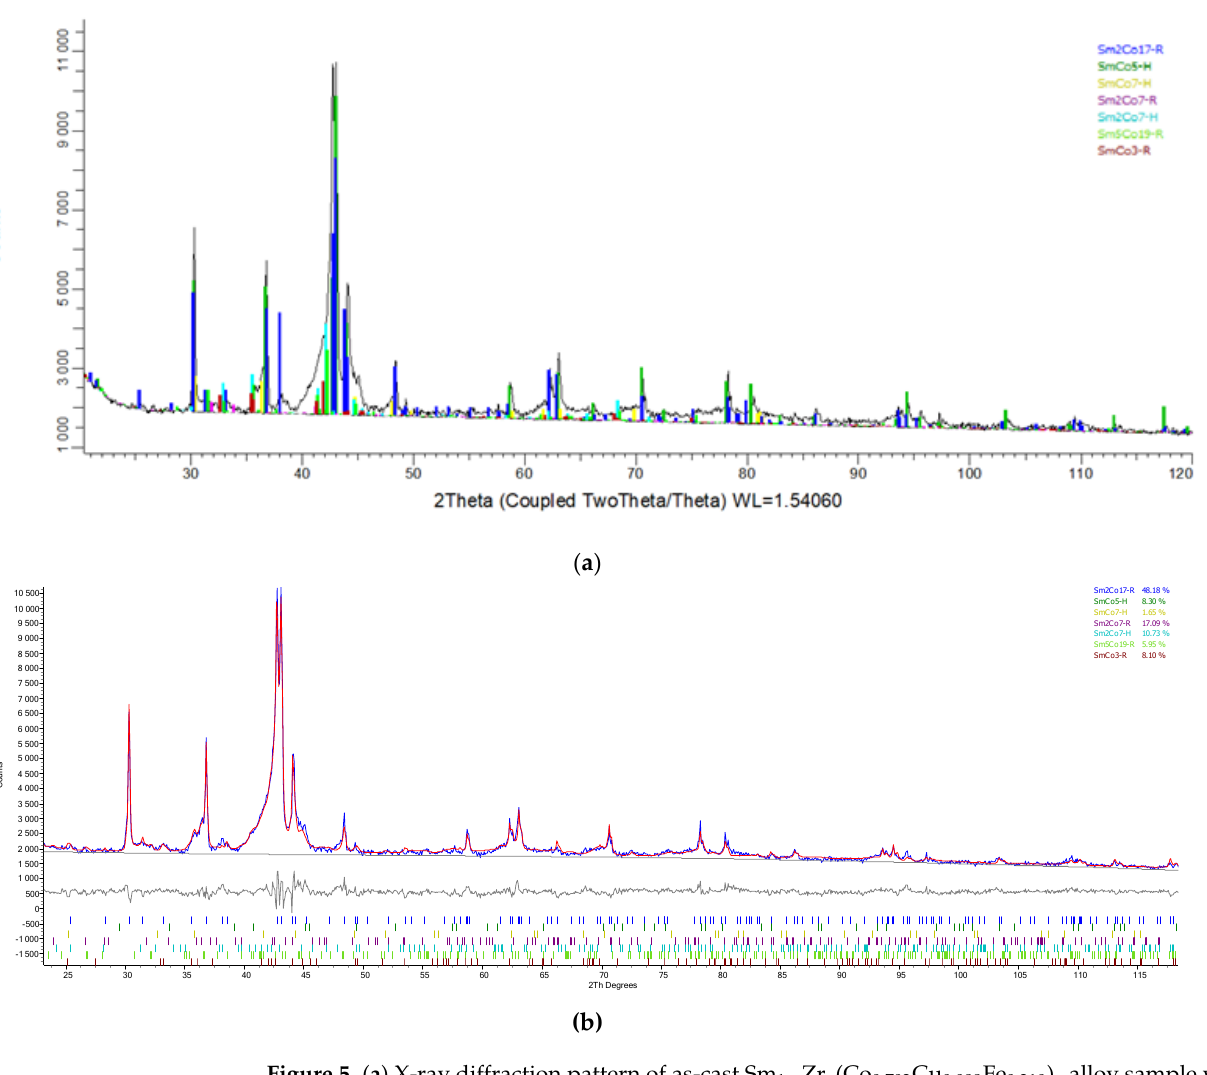
Figure 5. ( a ) X-ray diffraction pattern of as-cast Sm 1- x Zr x (Co 0.702 Cu 0.088 Fe 0.210 ) z alloy sample with x = 0.13 and z = 6.4; ( b ) Rietveld refinement of the pattern. Table 2. Crystal lattice and fine structure parameters of the phases identified in the as-cast Sm 1-